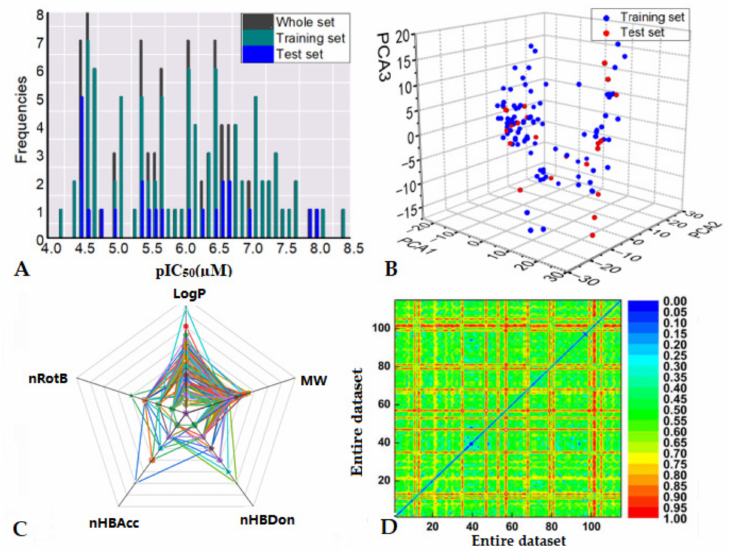
Figure 1. ( A ) Distributions of the experimental pIC 50 values for the whole dataset (n = 115, grey bars), training set (n = 92, green bars), and test set (n = 23, blue bars); ( B ) Chemical space of the entire dataset (n = 115) using top three principal components of dragon molecular descriptors (57% variance explained). ( C ) Radar map of molecular properties of the entire dataset; ( D ) Heat map of molecular similarity constructed by Euclidian distance metrics for the entire